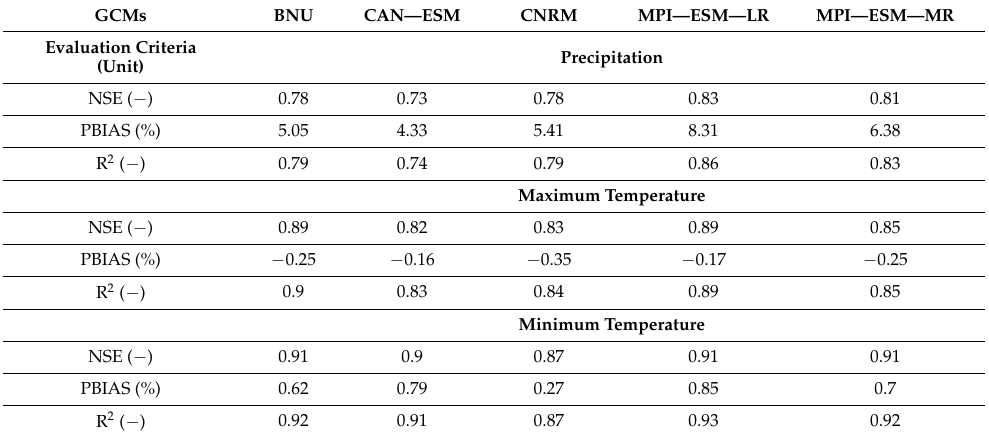
Table 3. Historical GCM statistical analysis, including NSE, PBIAS, and R 2 values, for monthly precipitation, maximum temperature, and minimum temperature datasets during 1981 and 2010. GCMs BNU CAN—ESM CNRM MPI—ESM—LR MPI—ESM—MR Evaluation Criteria (Unit) Precipitation NSE ( − )